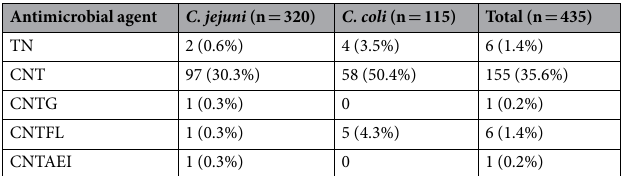
Table 3. Multidrug resistance patterns among C. jejuni and C. coli isolates from feedlot cattle. A, Azithromycin; C, Ciprofloxacin; E, Erythromycin; T, Tetracycline; F, Florfenicol; N, Nalidixic acid; I, Telithromycin; L, Clindamycin.